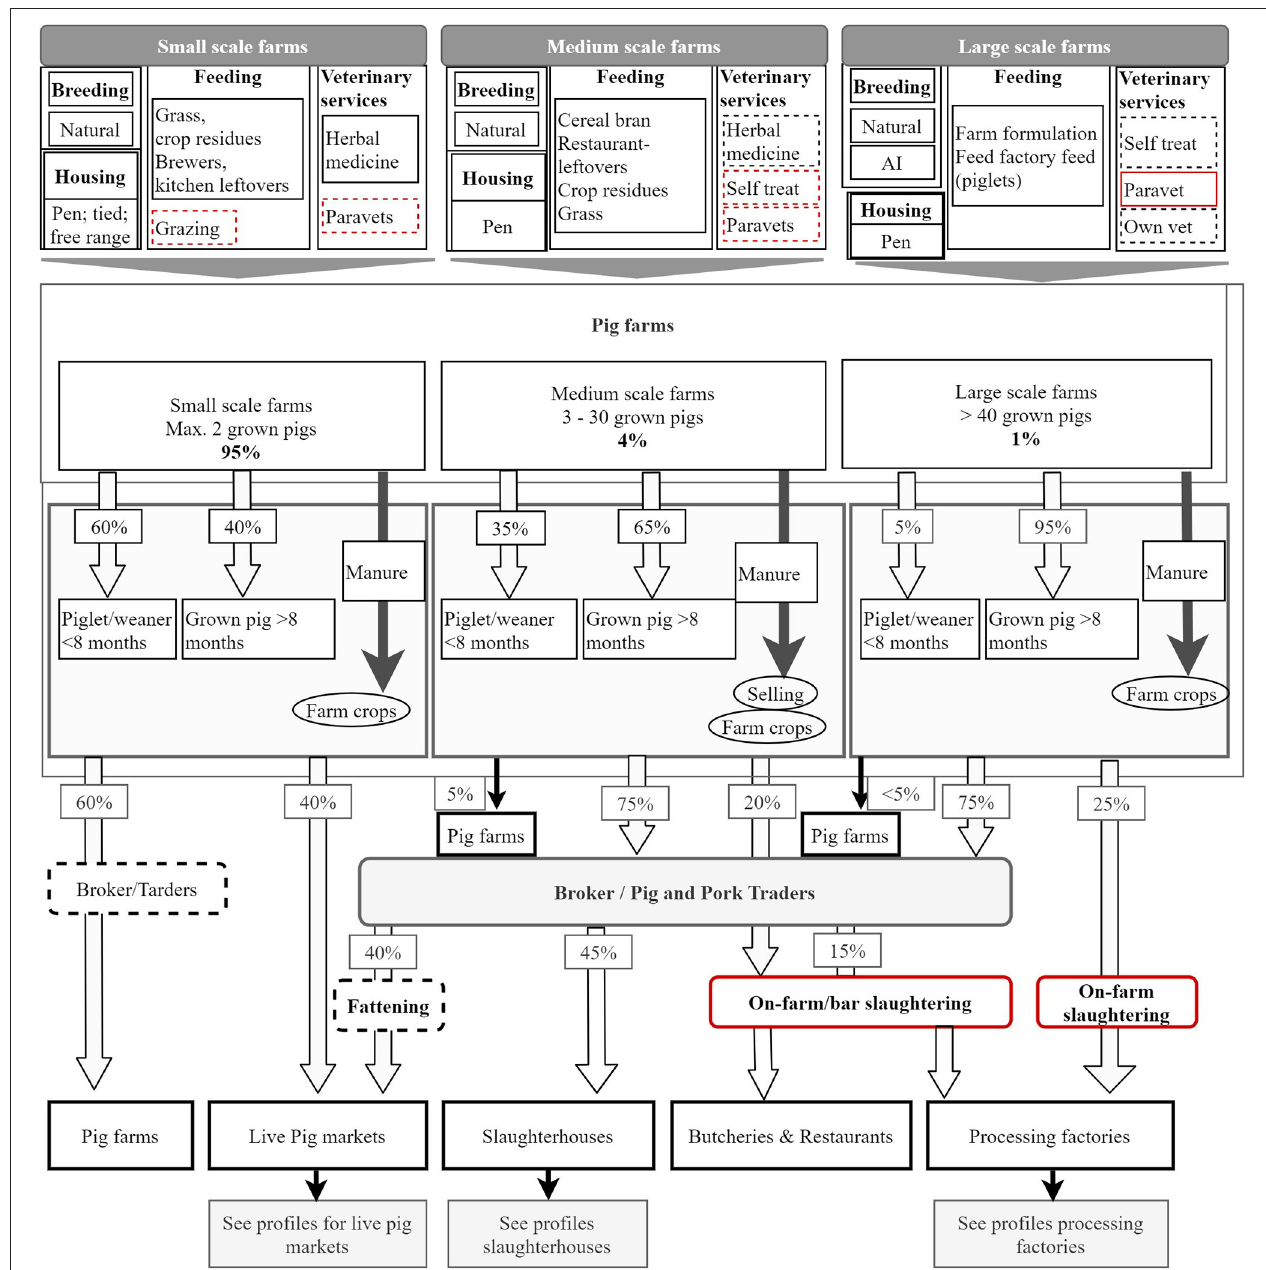
FIGURE 3 | Profile of Rwanda pig farms. Flowchart indicates origins and destination of pigs depending on type of farm. The characteristics of each farming system are summarised at the top and the approximate percentage of each pig category sold is indicated. Red boxes indicate sanitary risks and dotted boxes show occasional flow